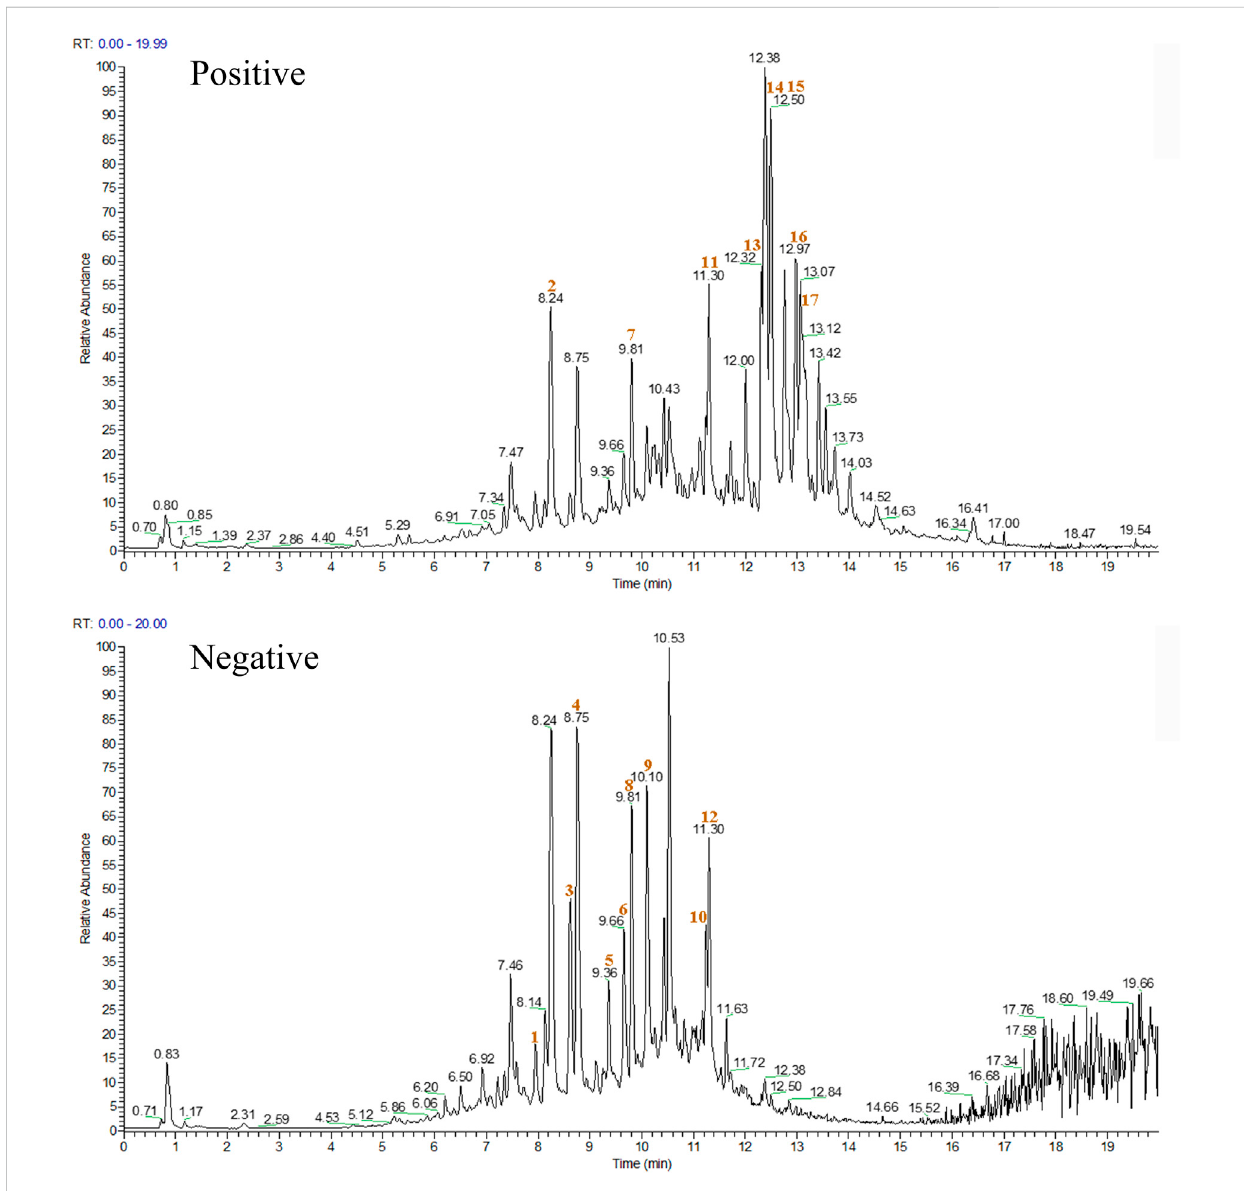
FIGURE 1 The chromatogram of XJS in positive and negative ion modes. The red number indicated the location of the 17 chemical